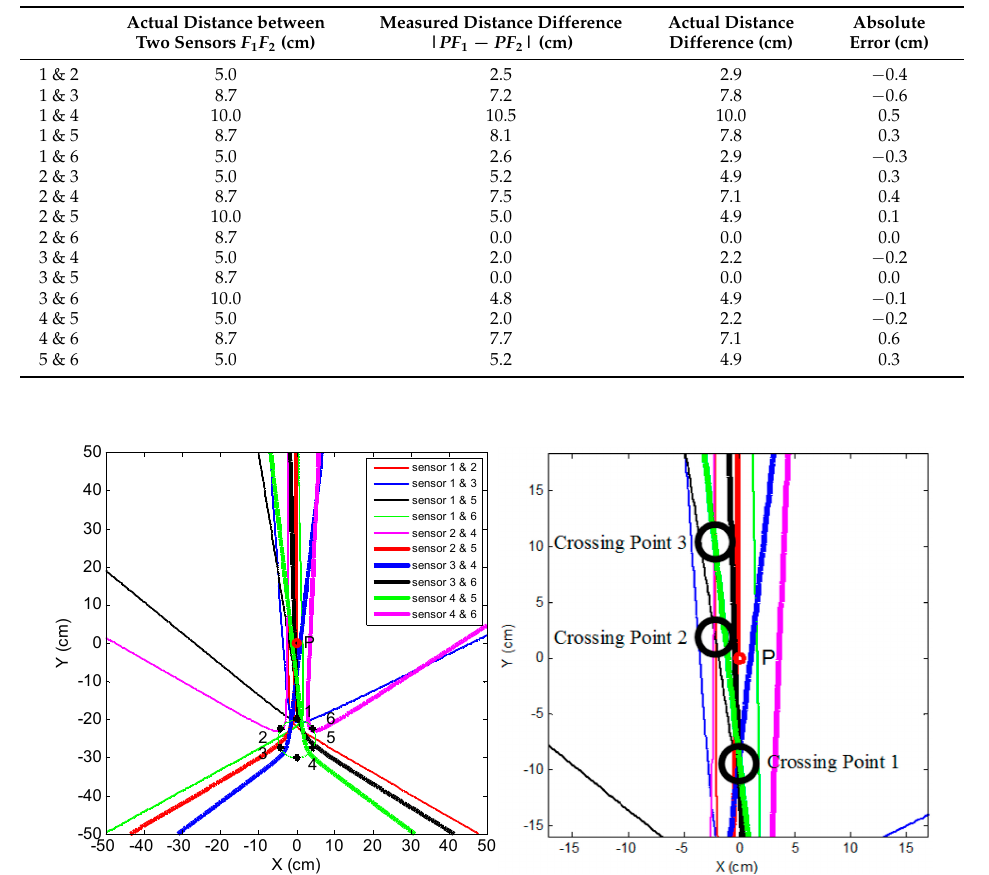
Table 2. Measured distance difference and corresponding error.